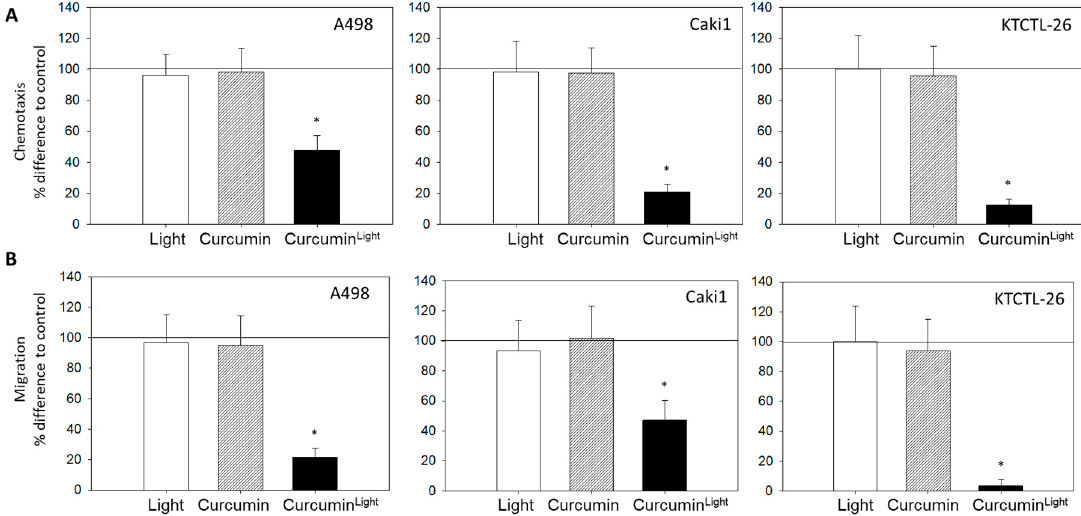
Figure 4. Influence of curcumin (0.2 µg/mL), light, or curcumin Light on chemotaxis towards a serum gradient ( A ) and migration through a collagen matrix ( B ). Endpoints after 24 h. Untreated control cells were set to 100%, indicated by a line drawn at 100%. 5 separate fields of 0.25 mm 2 were counted at 200× magnification (means ± SD, n = 6). * indicates significant difference to controls ( p = 0.00512). Tumor cell migration through a collagen matrix towards a serum gradient was also evaluated. Curcumin or light alone did not alter the trans-migration rate, whereas curcumin Light did (Figure